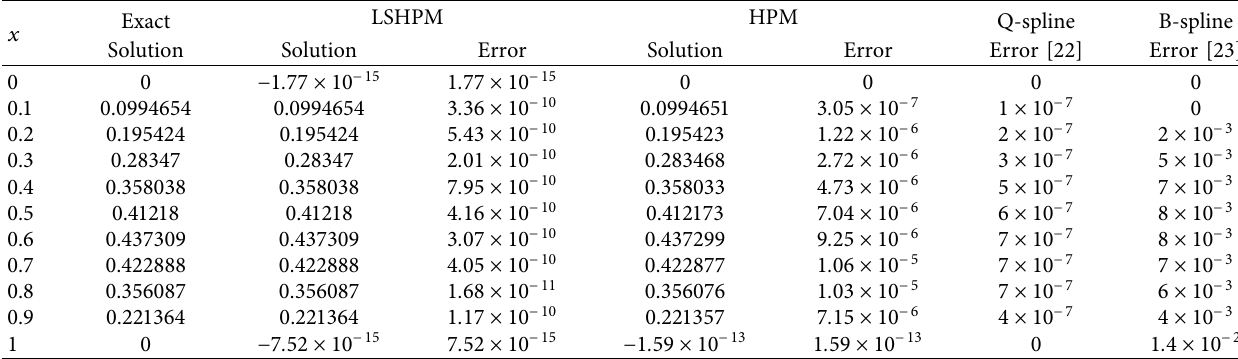
Table 3: Comparison of second-order absolute error of LSHPM with HPM, Q-spline, and B-spline in Problem 3.